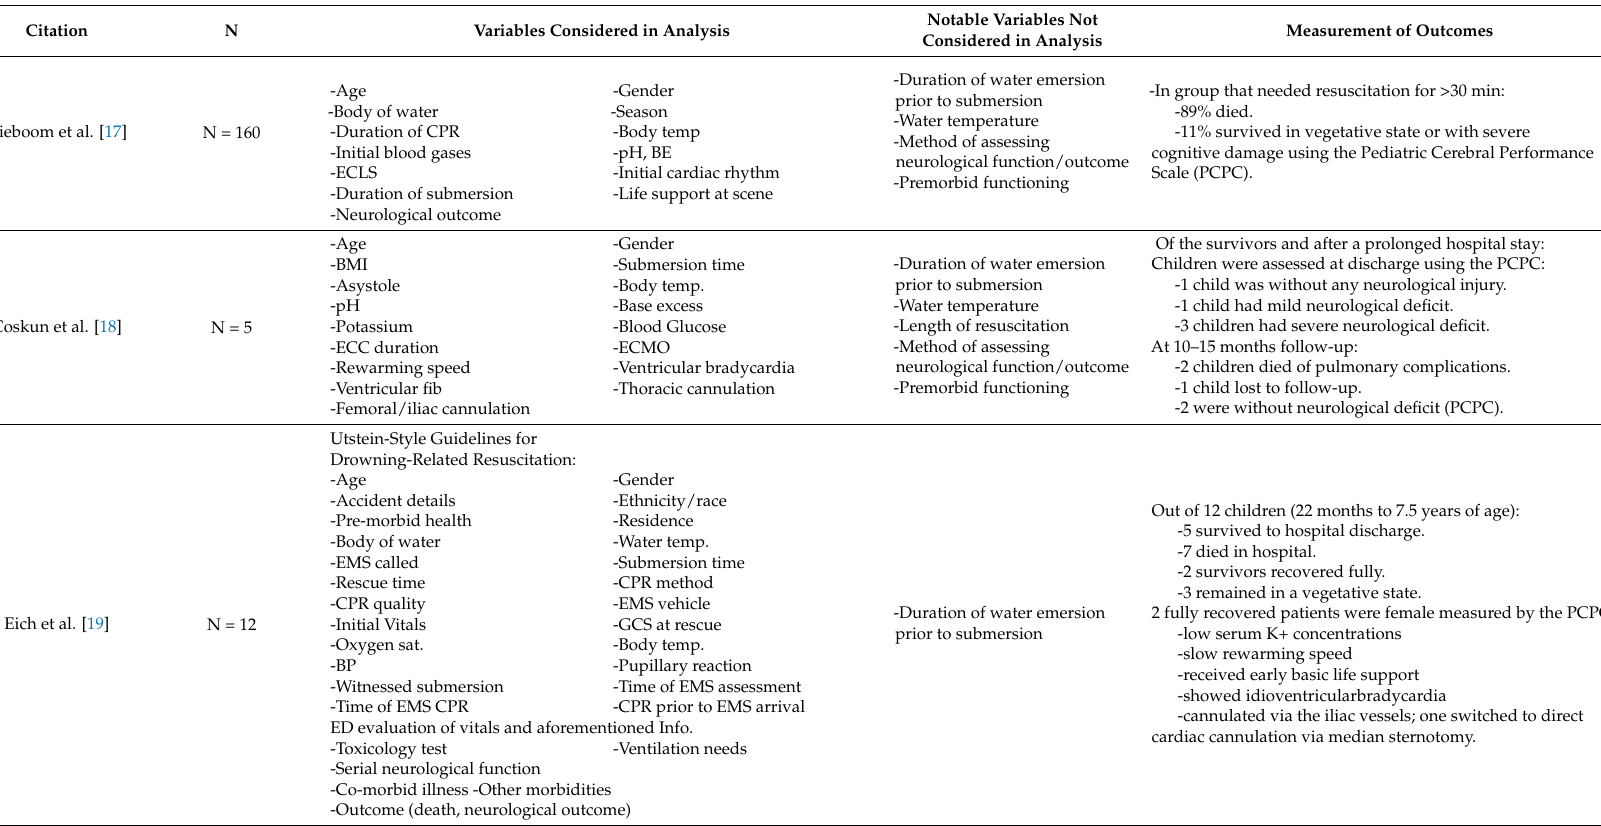
Table 3. Published studies since 2007 analyzing outcomes with cold water submersion hypothermic cardiac arrest in pediatric non-fatal